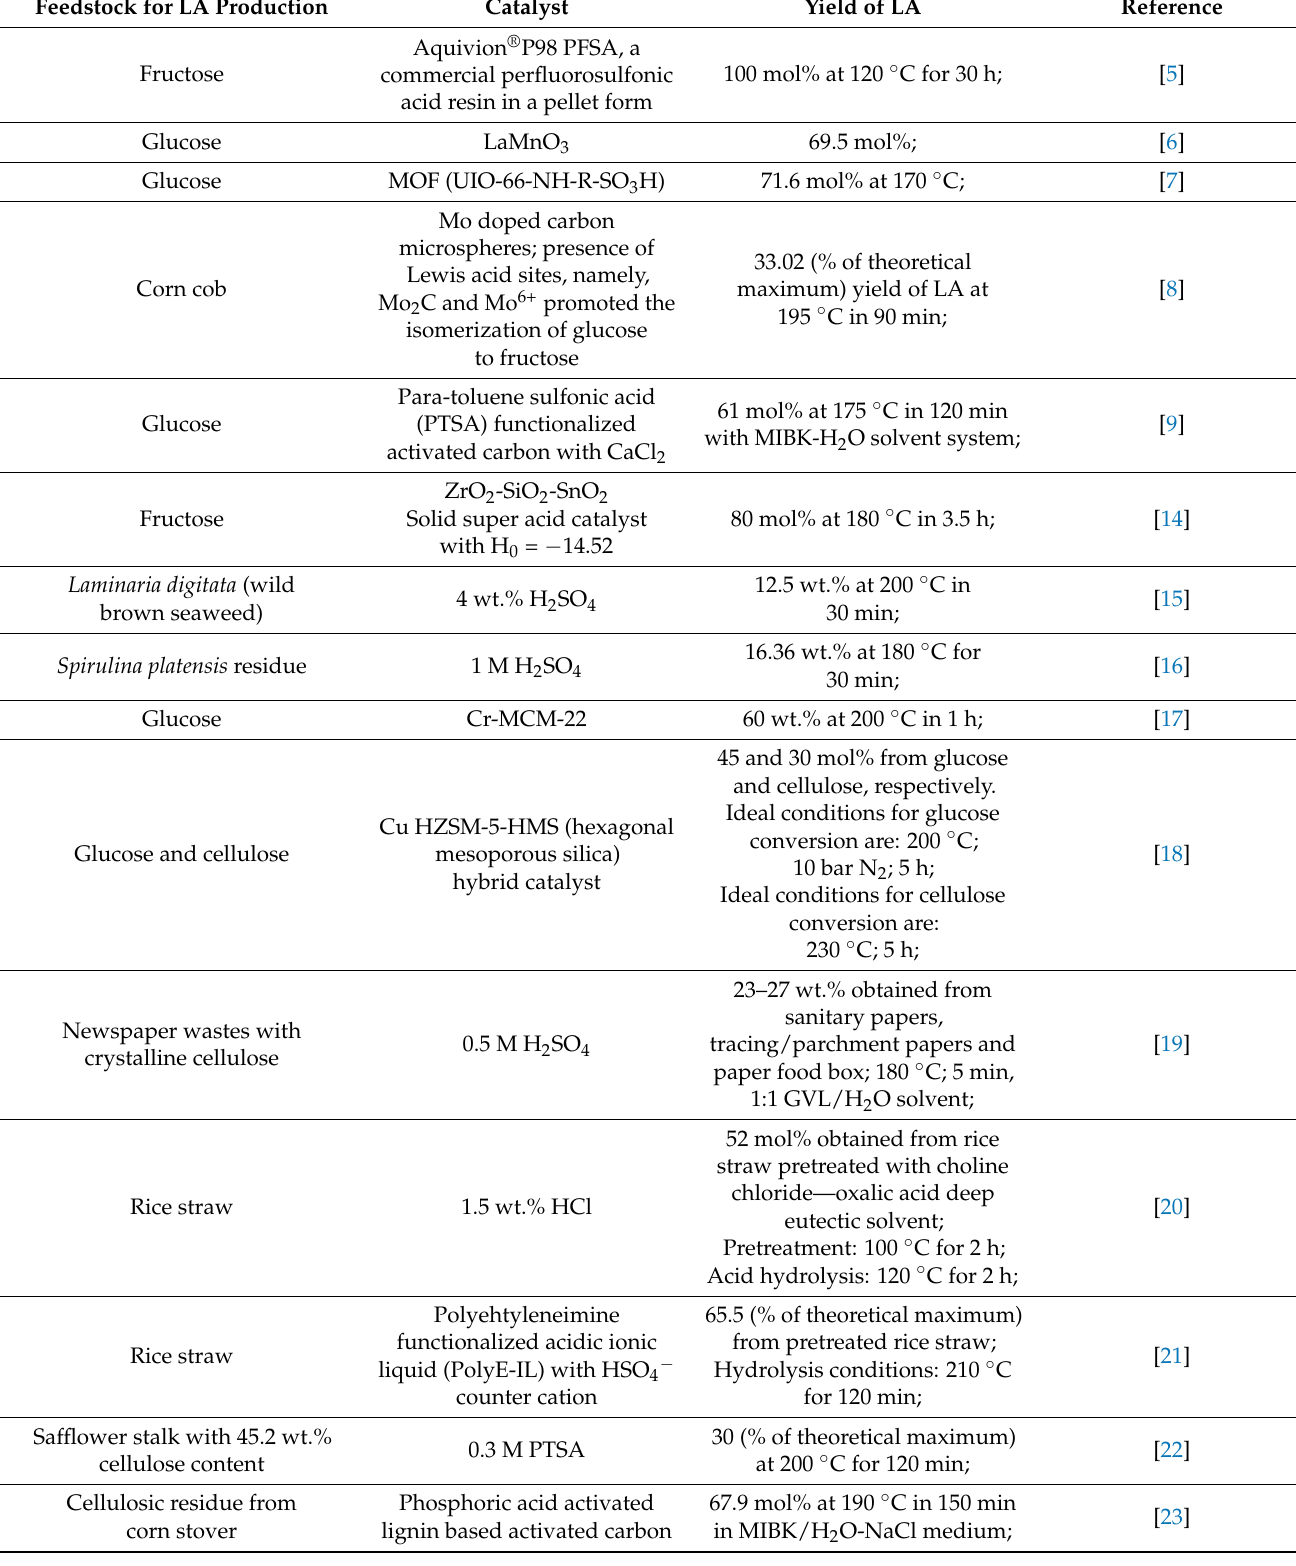
Table 1. Diverse biomass feedstock and catalysts used for levulinic acid (LA)